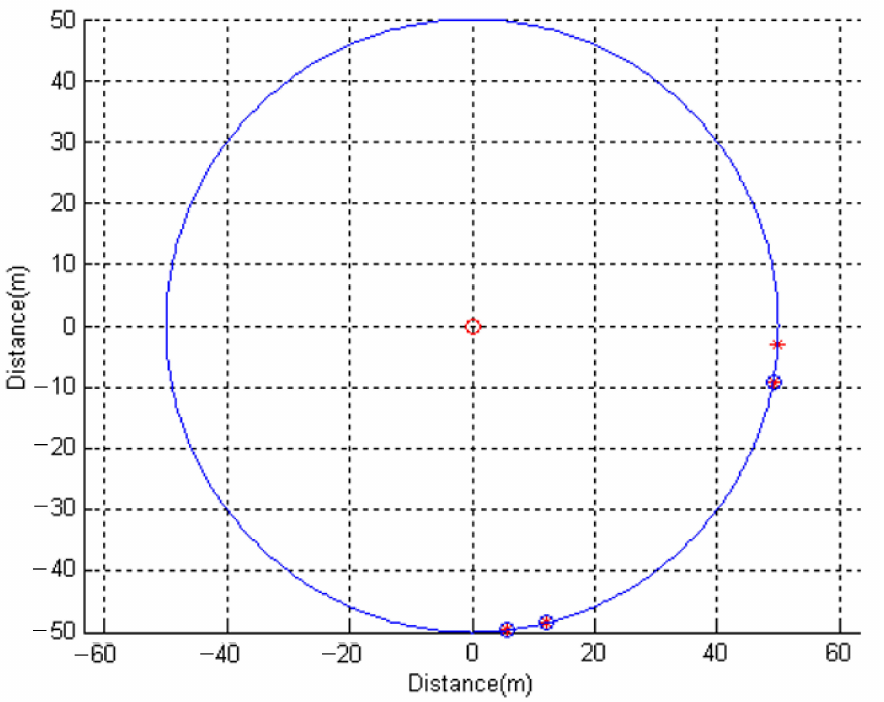
Figure 5. Implementation of the four-to-three mechanism on the circle. * stands for that node is not